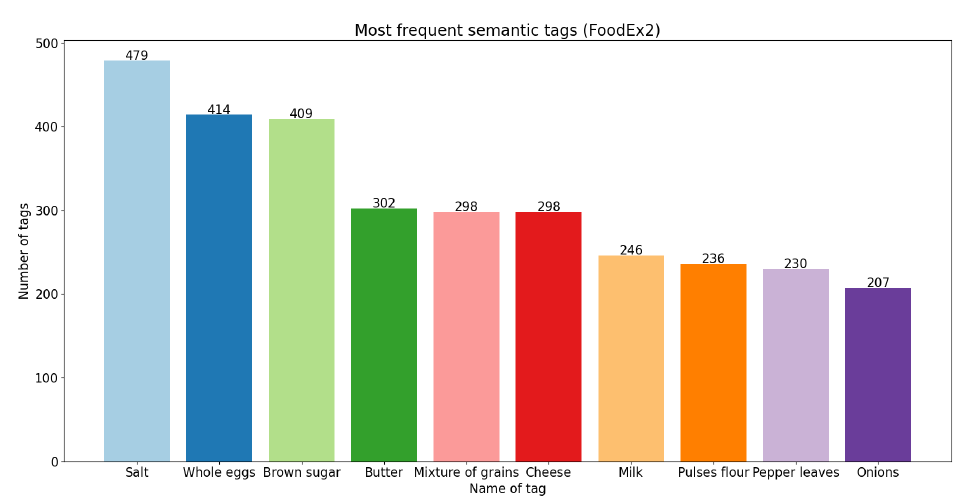
Figure 8. Ten most frequent semantic tags from